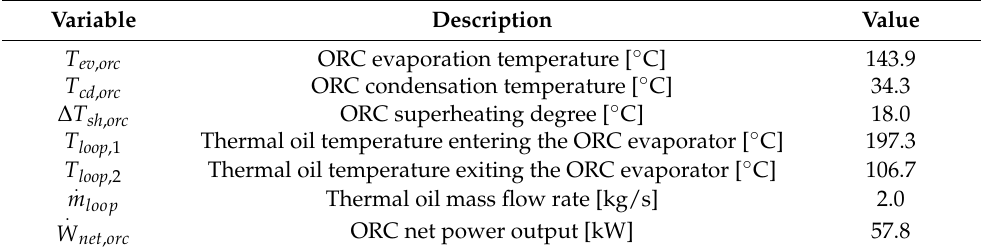
Table 3. Organic rankine cycle (ORC) and thermal oil loop variables and ORC net power output for the design corresponding to the most populated cluster (Cluster